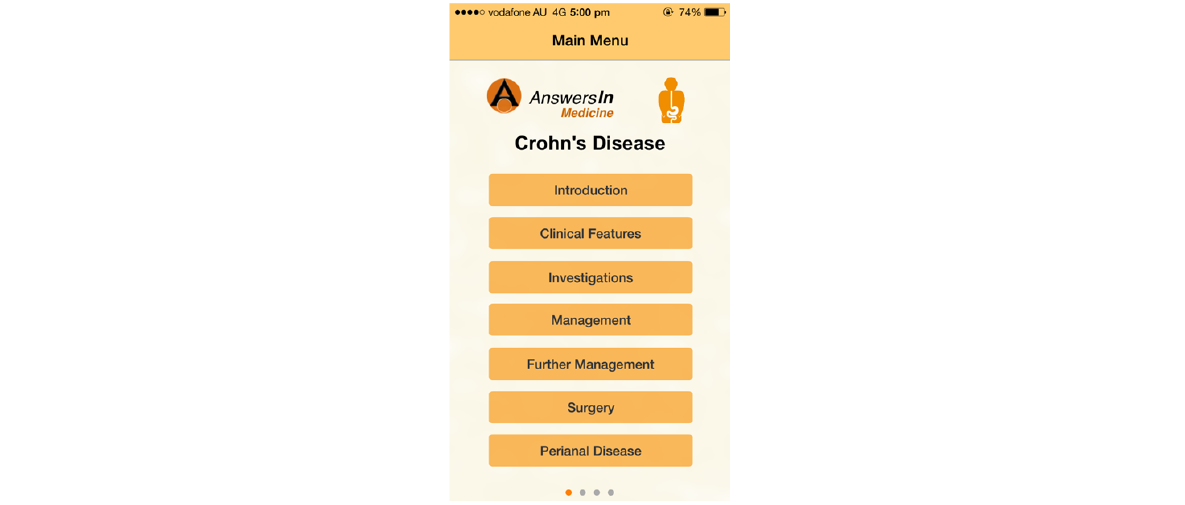
Figure 2. Screenshot of the main menu of the app AnswersIn Crohn’s Disease.